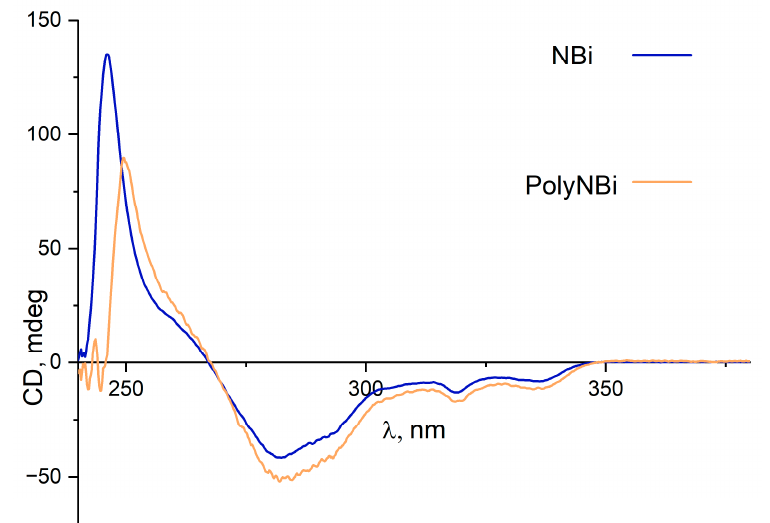
Figure 3. Circular dichroism spectra of the monomer and metathesis polymer based on the ester of exo -5-norbornenecarboxylic acid and 1,1 ′ -bi-2-naphthol in CHCl 3 at 25 °C (the concentration of both samples is 1 mg/mL).